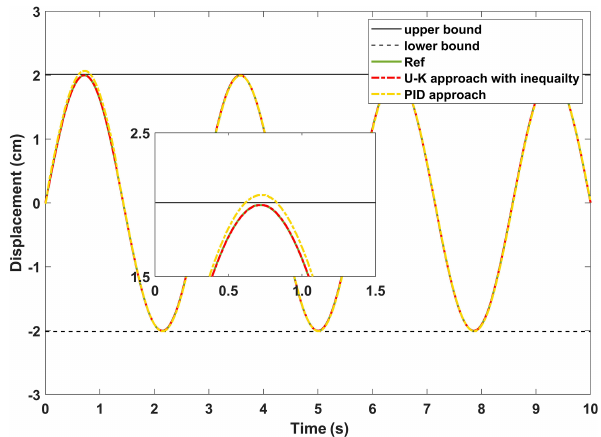
Figure 14. The experimental error of the steady-state performance of the U–K equality constraint and PID.